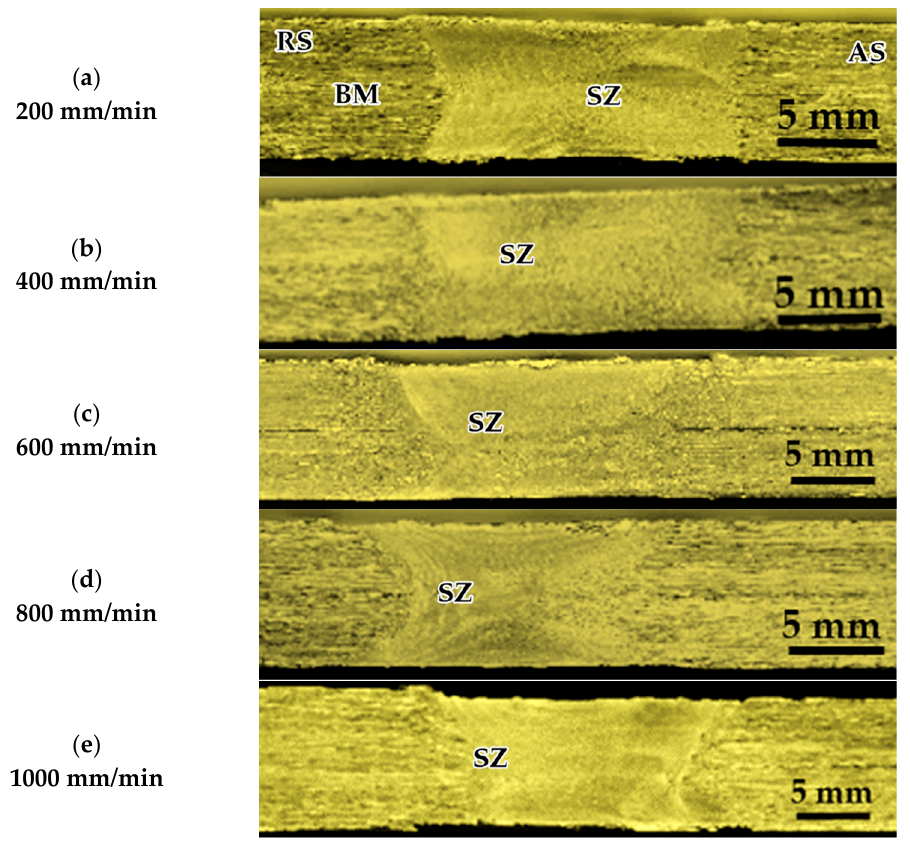
Figure 17. Macrographs of transverse cross-sections of lap joints produced at 600 rpm rotation speed and different travel speeds of ( a ) 200, ( b ) 400, ( c ) 600, ( d ) 800, and ( e ) 1000 using BT with Cy pin.